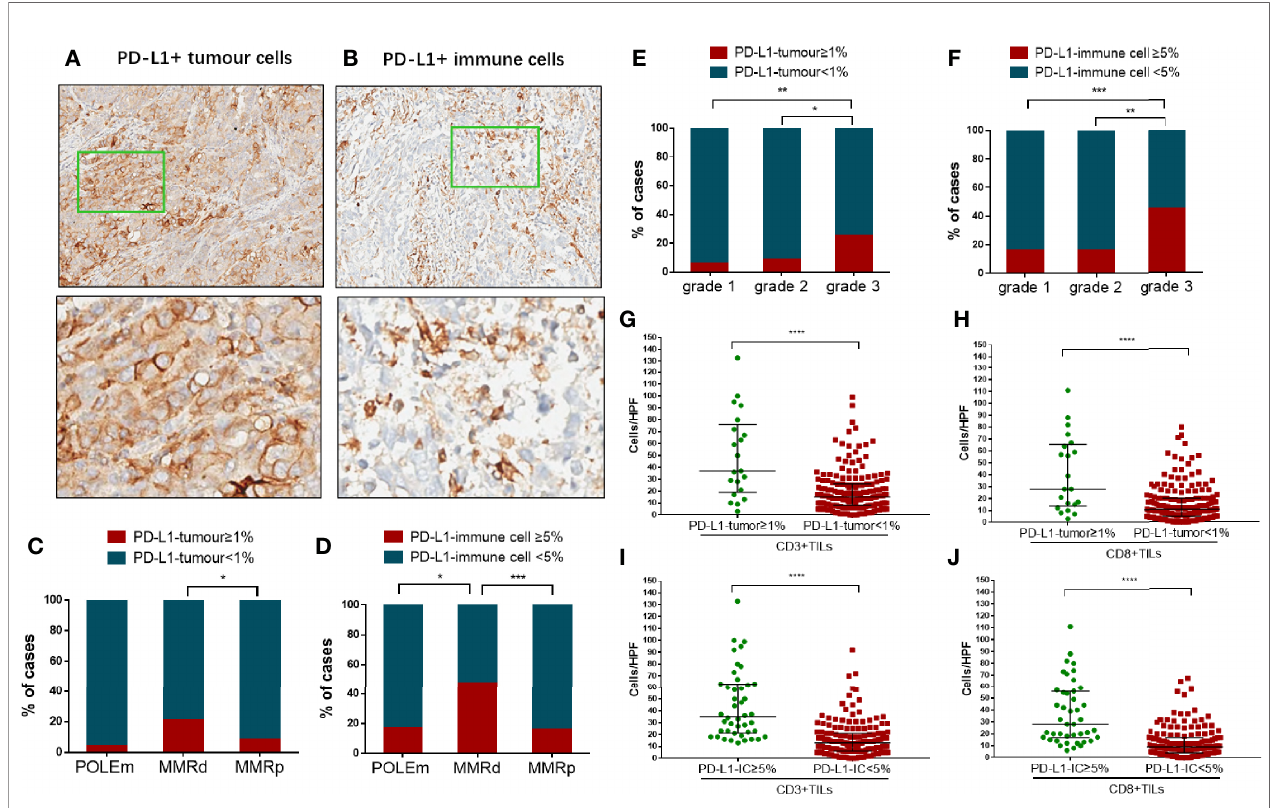
FIGURE 2 | Analysis of PD-L1 expression in tumor cells and immune cells in endometrial cancer. (A) A representative case showed PD-L1 positivity in tumor cells. Images in the bottom show details of the areas indicated by green boxes in the images above. Magni fi cation: 5× (top) and 200× (bottom). (B) A representative case showed PD-L1 positivity in immune cells. Images in the bottom show details of the areas indicated by green boxes in the images above. Magni fi cation: 5× (top) and 200× (bottom). (C) Proportion of cases positive/negative for PD-L1 in tumor cells in POLEm, MMRd and MMRp tumors. (D) Proportion of cases positive/negative for PD-L1 in immune cells in POLEm, MMRd and MMRp tumors. (E) Proportion of cases positive/negative for PD-L1 in tumor cells in ECs with different differentiation. (F) Proportion of cases positive/negative for PD-L1 in immune cells in ECs with different differentiation. (G) Comparison of CD3+TILs between cases with positive or negative expression of PD-L1 (tumor cells). (H) Comparison of CD8+TILs between cases with positive or negative expression of PD-L1 (tumor cells). (I) Comparison of CD3+TILs between cases with positive or negative expression of PD-L1 (immune cells). (J) Comparison of CD8+TILs between cases with positive or negative expression of PD-L1 (immune cells). POLEm, POLE mutation; MMRd, MMR de fi ciency; MMRp, MMR pro fi ciency. Chi-square test and Fisher ’ s exact test were used, with p <0.05 indicating statistical signi fi cance. *P <0.05; **P <0.01; ***P